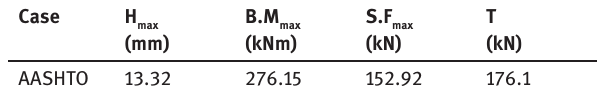
Table 8: Results of analysis with American